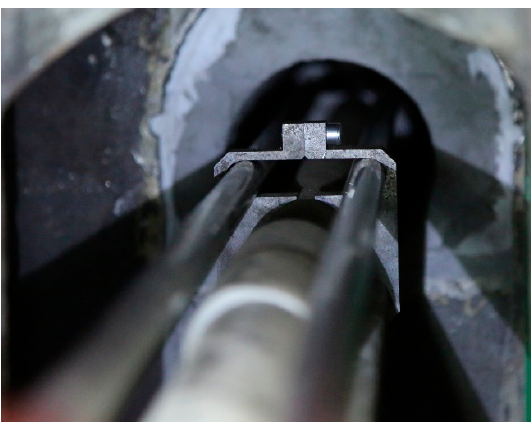
Figure 11. Working photo of the micro tunnel boring machine (TBM) excavation device.